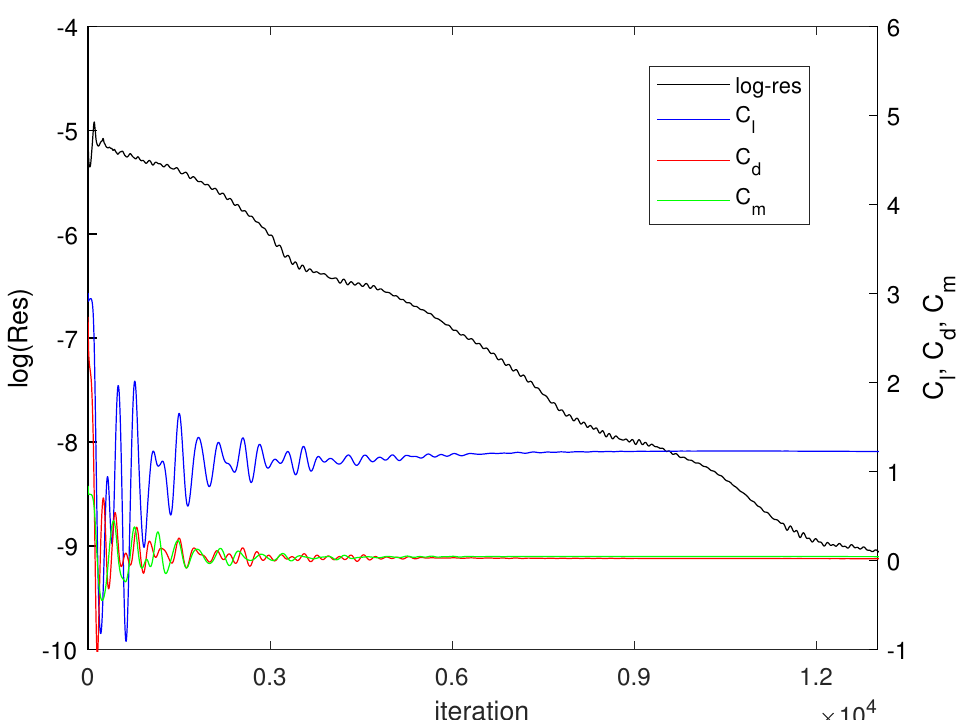
Figure 9. Residuals and aerodynamic coefficients versus iteration number of the NLR 7301 airfoil for M ∞ = 0.185 and α = 10.1 ◦ .